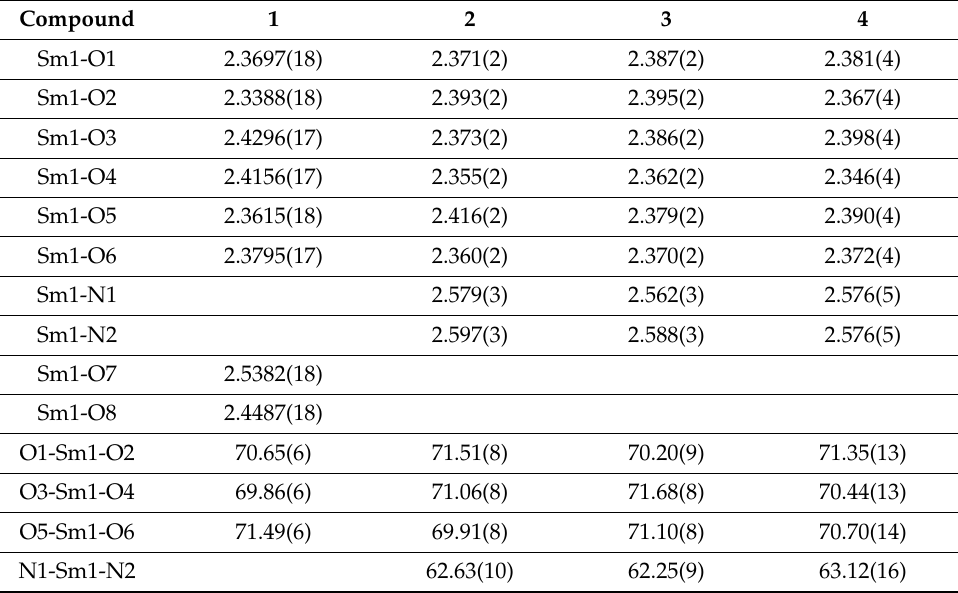
Figure 2. Coordination figures ( a – d ) of 1 – 4 compounds, respectively. Color code: turquoise: Sm, red: oxygen, and blue: nitrogen. Table 2. Selected bond distances (Å) and bond angles ( ◦ ) of 1 – 4